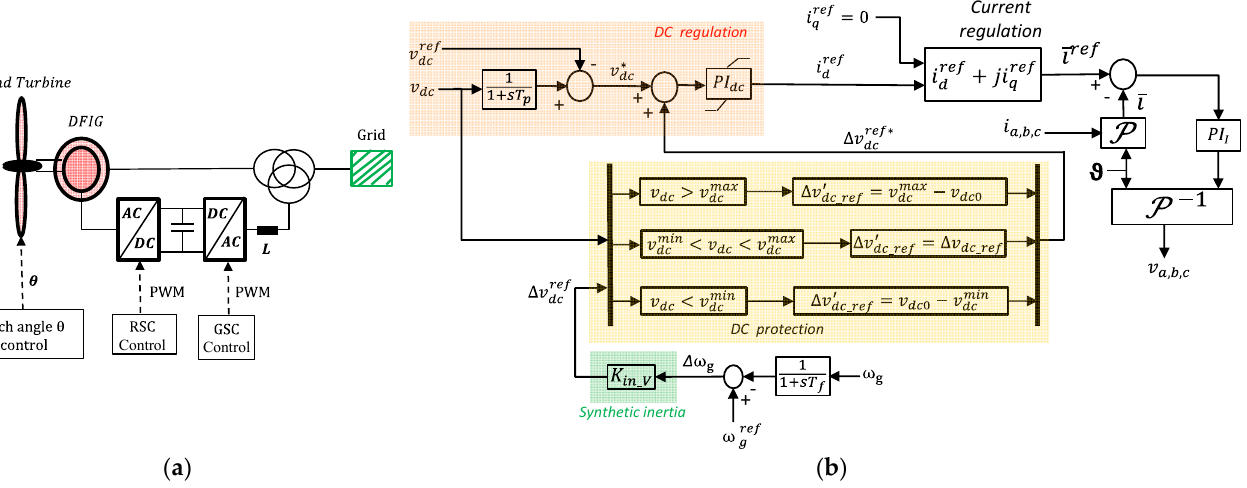
Figure 3. DFIG model [45] ( a ), and voltage controlled model for SI [4,46,47] ( b ).